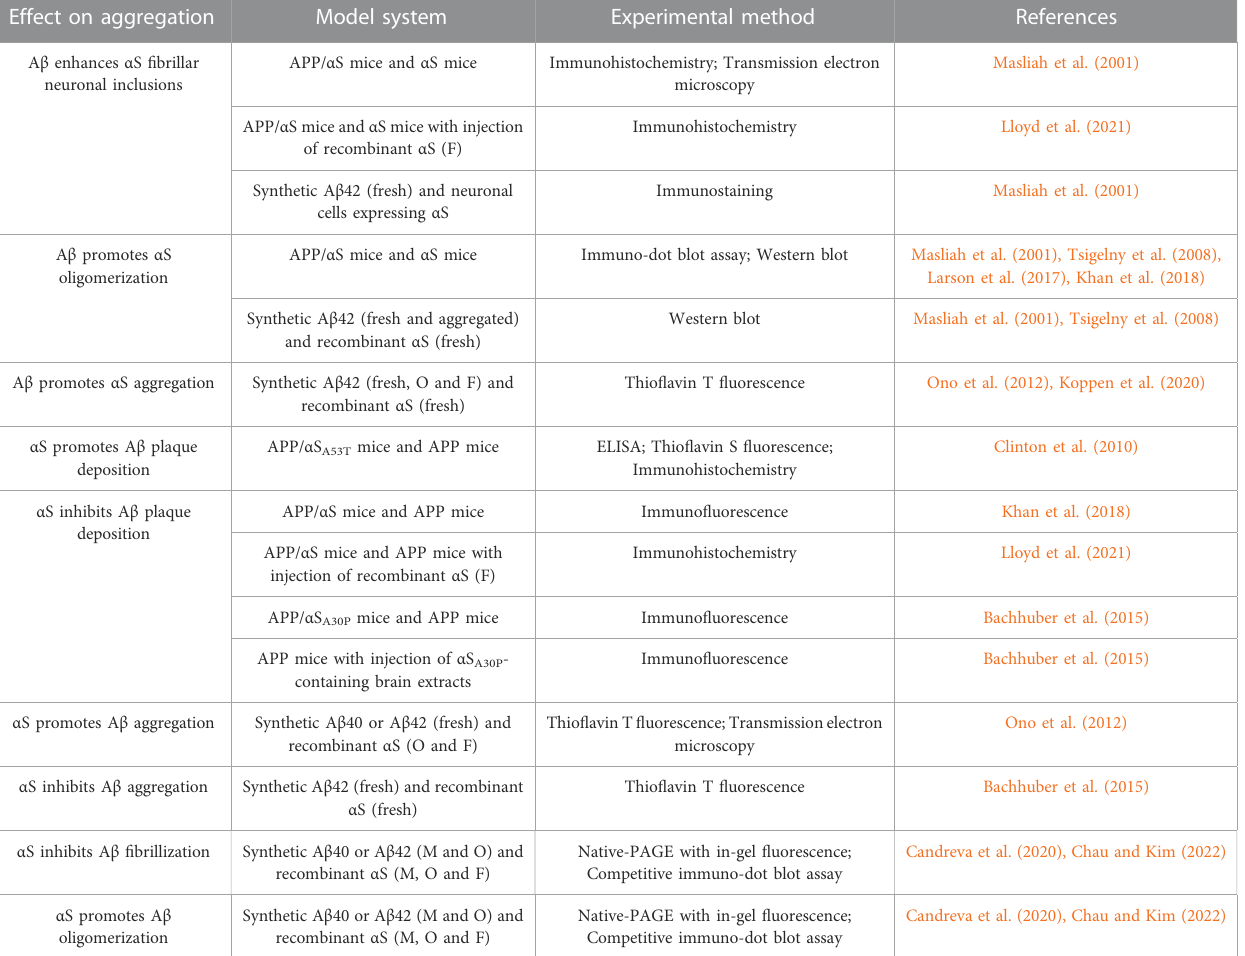
TABLE 1 Summary on effects of A β - α S interactions on